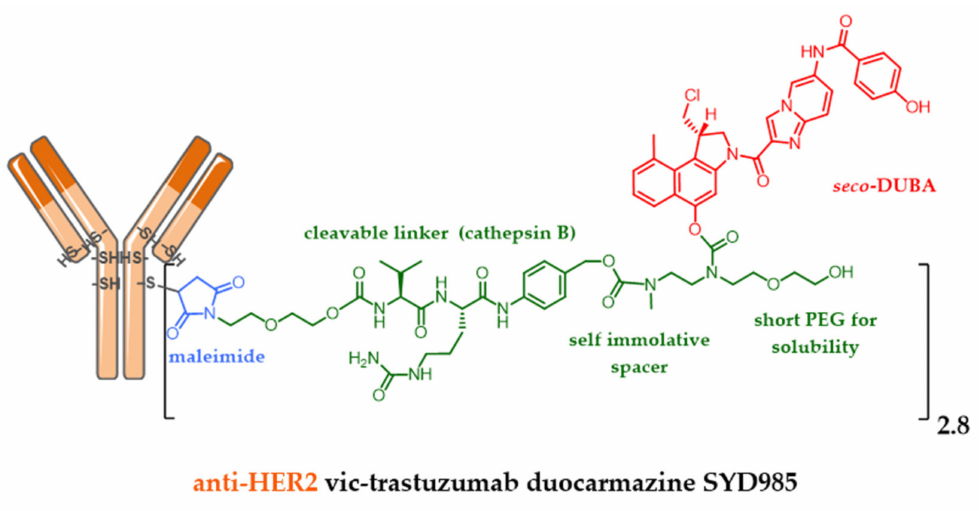
Figure 14. SYD985 formula, anti-HER2 trastuzumab conjugated to seco -DUBA via a cleavable linker sensitive to cathepsin B.